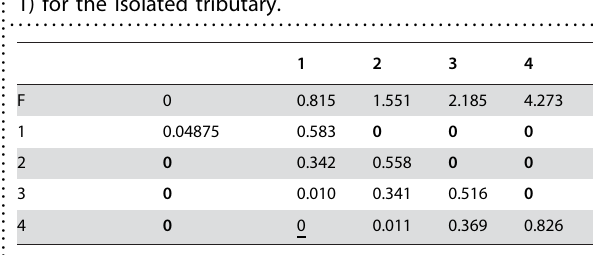
Table 2. Reference matrix describing monthly size-based survivals (1–4, see text for definition) and fecundities (F in